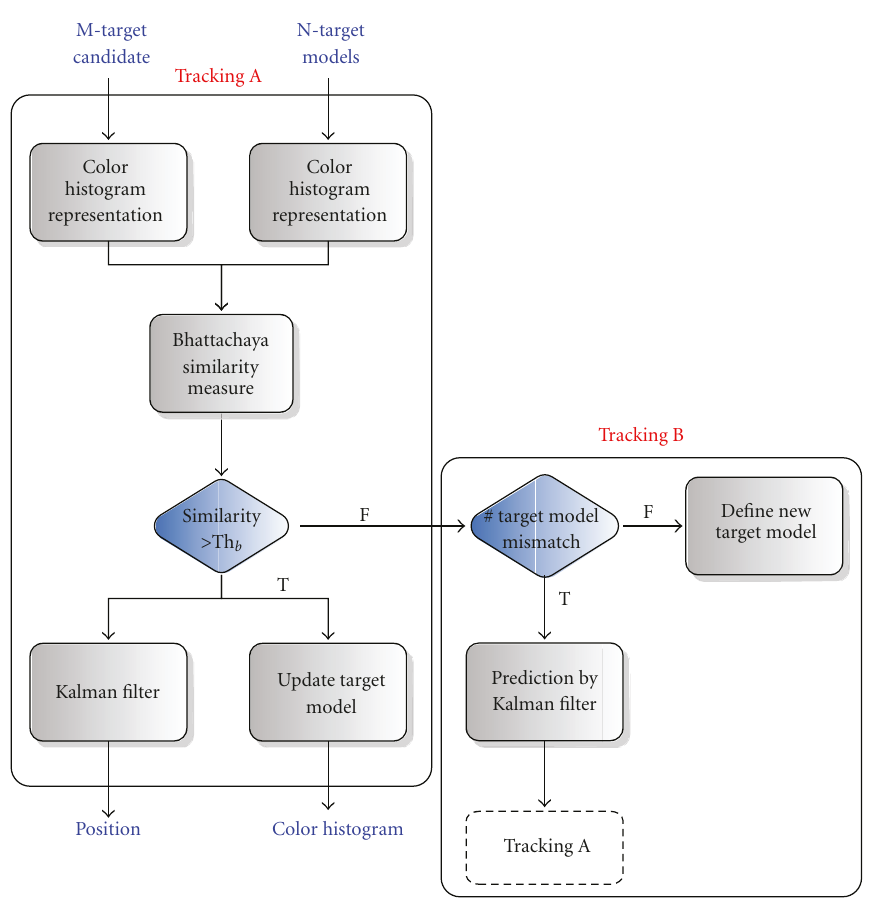
Figure 12: The tracking module.